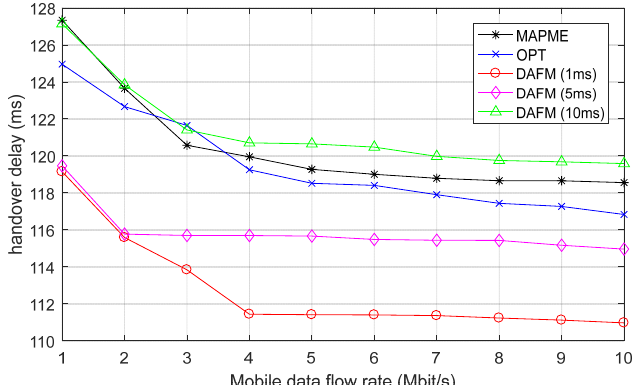
Figure 6. Comparison of handover delays between different mobility support methods.